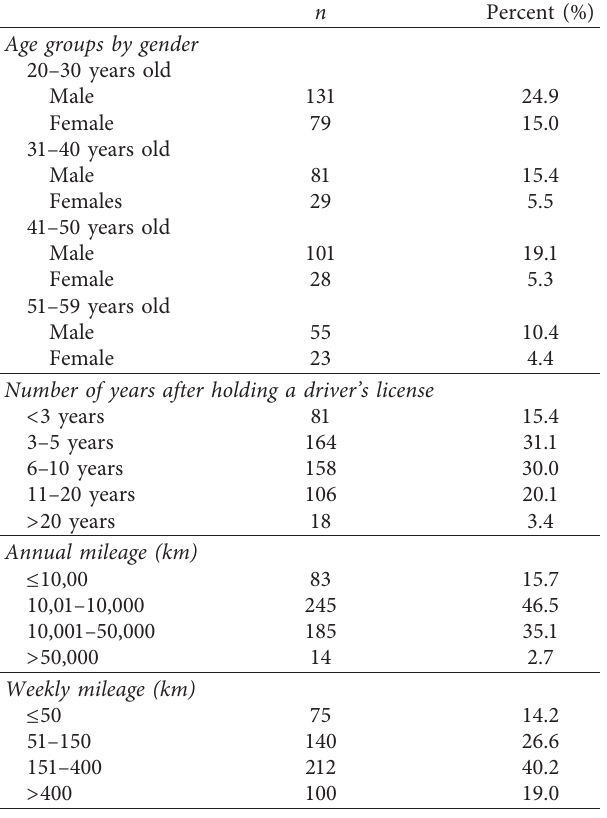
Table 1: Participant demographics ( N �